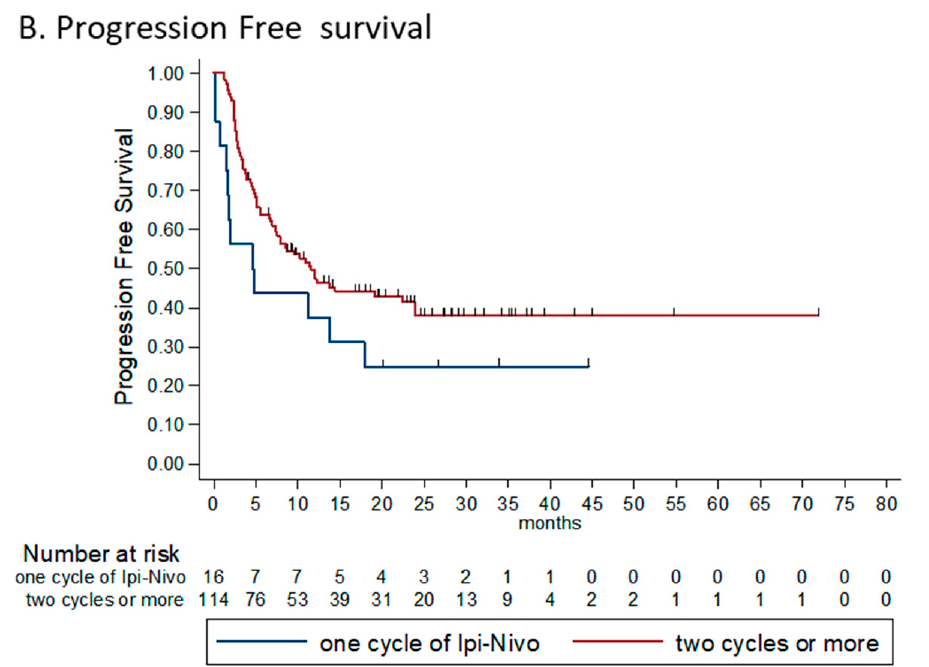
Figure 3. Kaplan-Meier survival estimates according to number of combinations received in the induction phase (stopped for toxicity only). ( A ) OS according to number of ipilimumab and nivolumab combinations received. HR for death 0.35 (95% CI 0.18–0.68, p = 0.002) for patients receiving two or more cycles, compared to patients who received only one cycle. Median OS were NR and 9.5 m, respectively. ( B ) PFS according to number of ipilimumab and nivolumab combinations received. HR for progression or